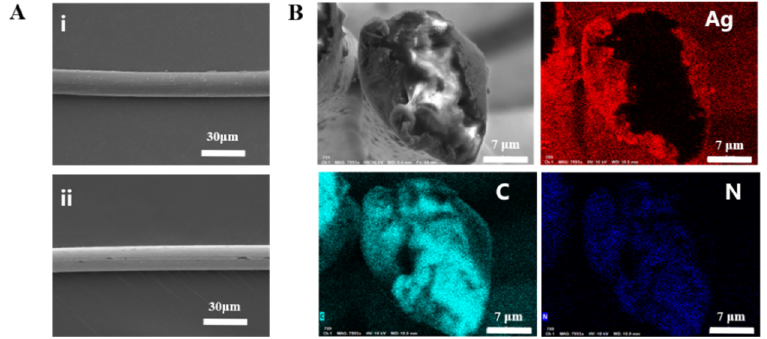
Figure 1. ( A ) SEM images of ( i ) PA fiber and ( ii ) Ag@PA fiber; ( B ) EDS element distribution image of Ag@PA fiber.